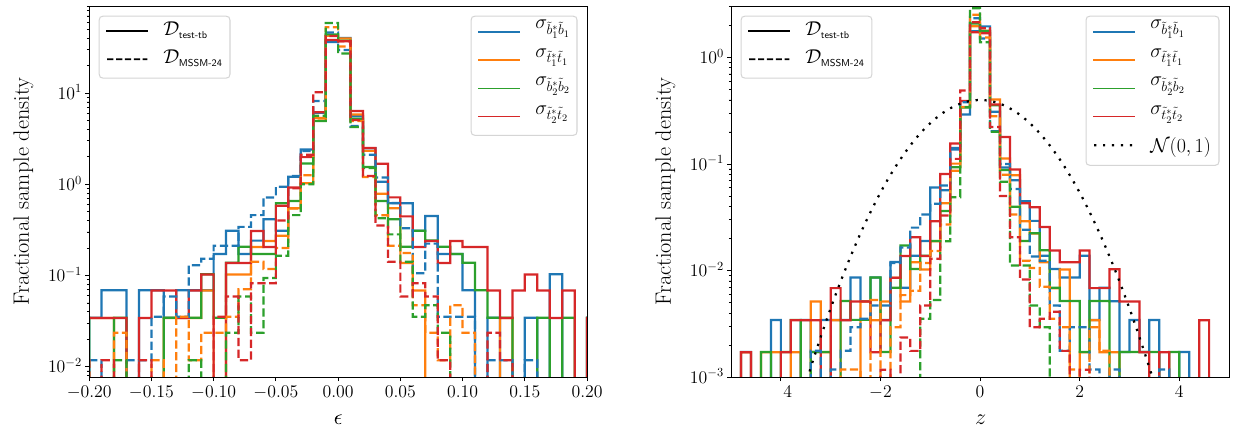
Fig. 21 Distributions for the relative error (left) and residual (right) for the stop and sbottom pair-production cross-sections for the test sets D test-tb (solid) and D MSSM-24